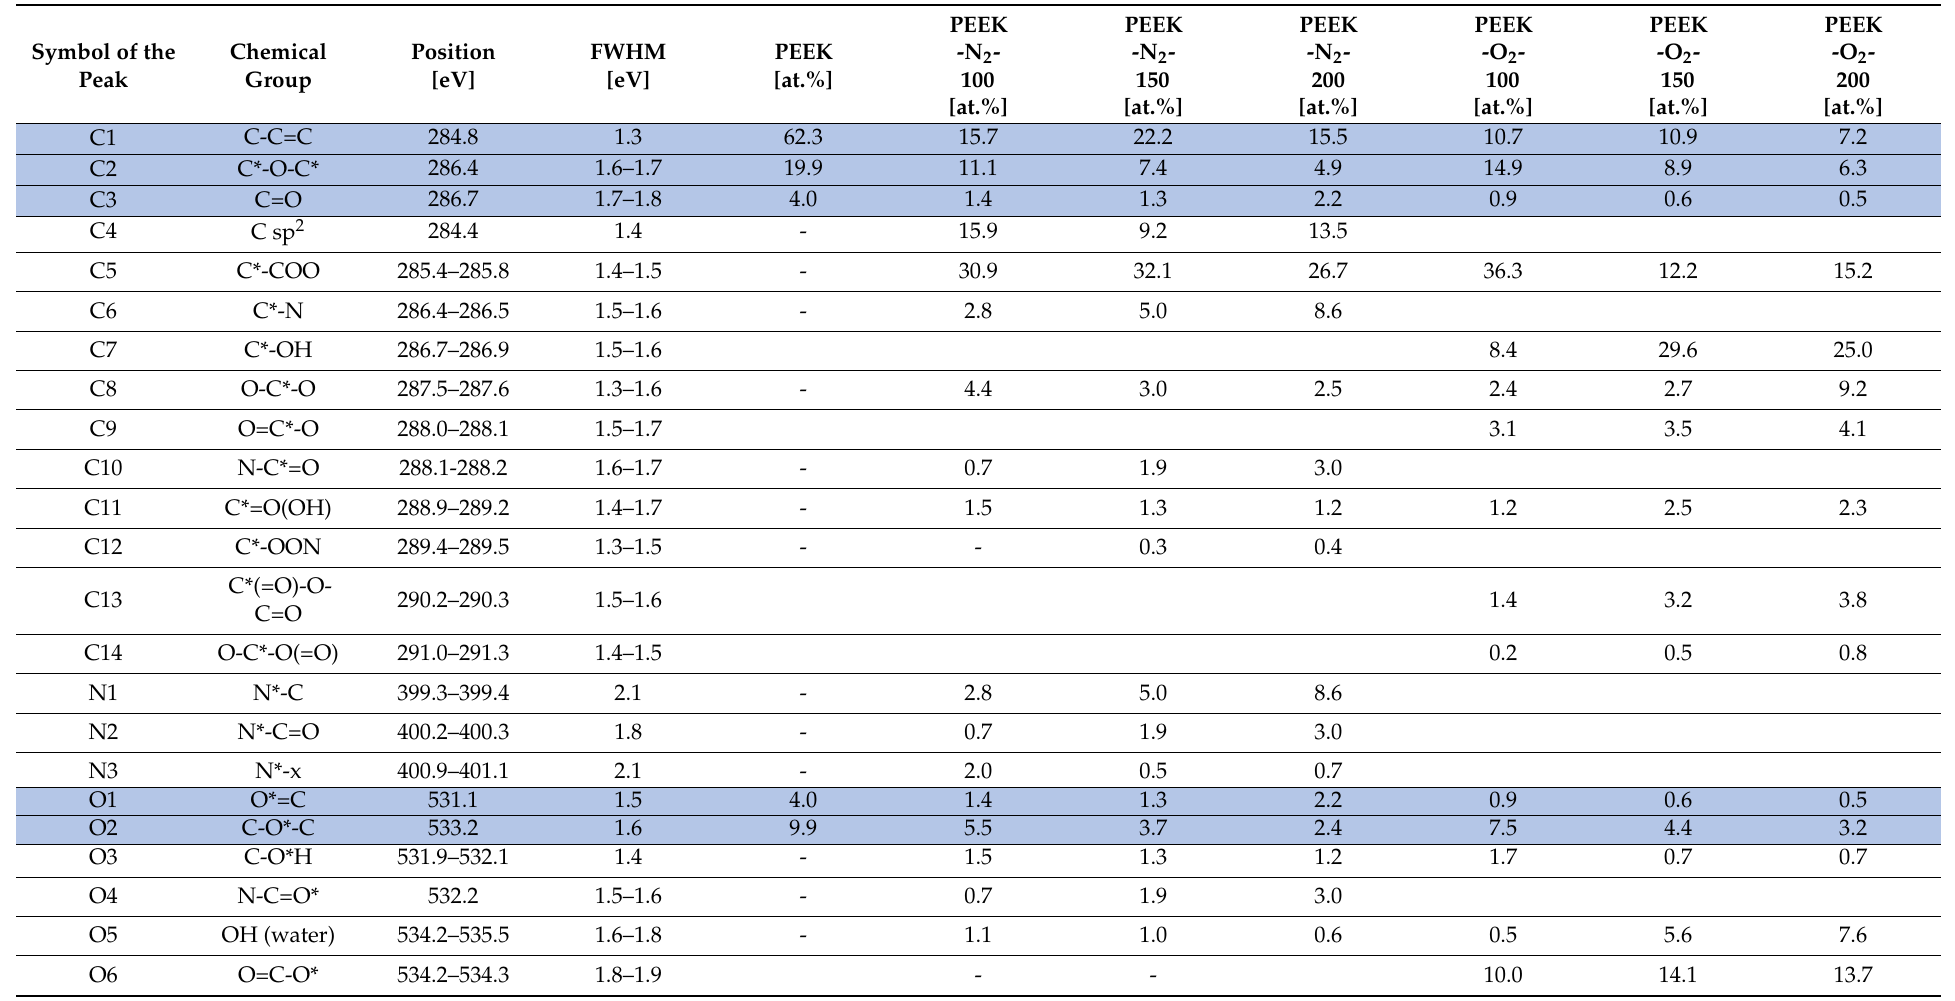
Table 1. Binding energy range, FWHM range, and atomic concentration of different functional groups for pristine PEEK and modified PEEK (pristine PEEK peaks given in rows with blue